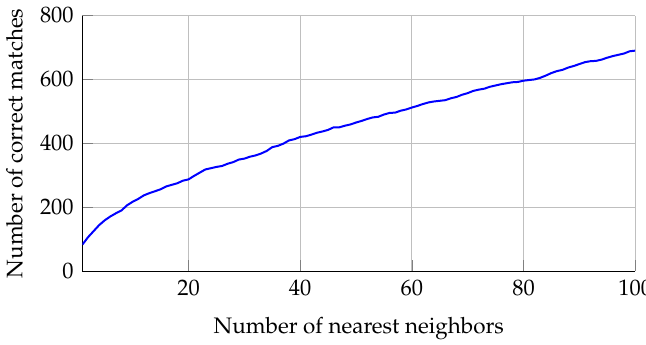
Figure 4. Cumulative number of possible correct matches considering multiple nearest neighbors in the feature matching for the Container